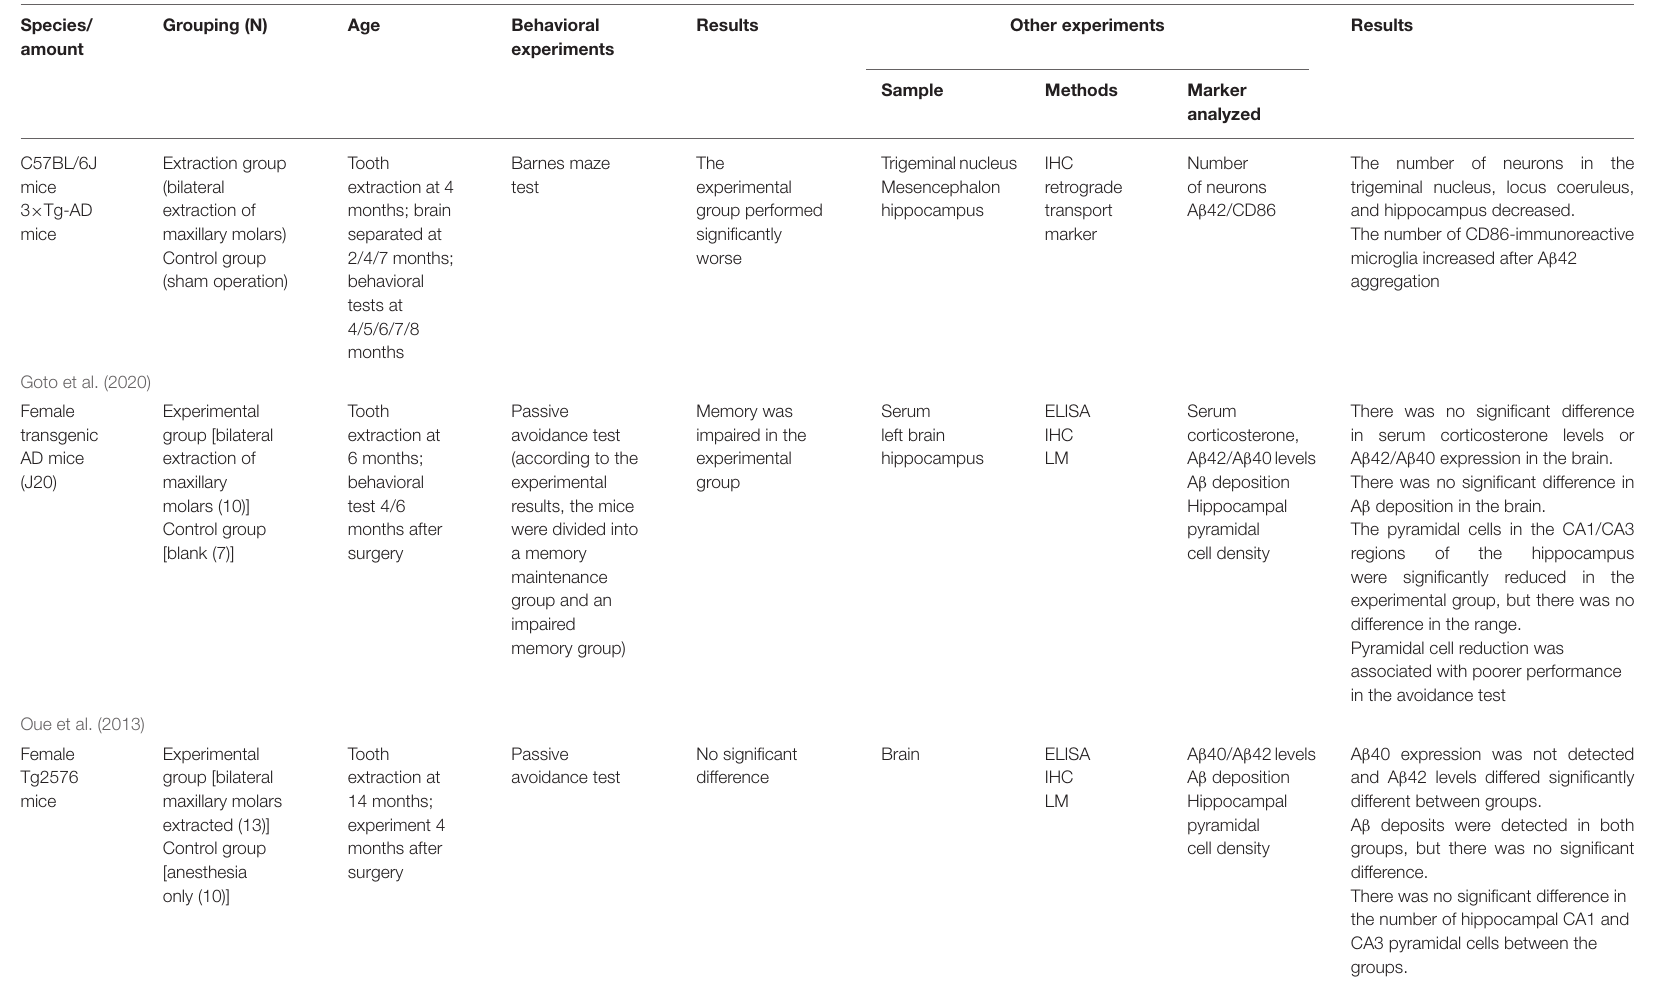
TABLE 4 | The aggravation